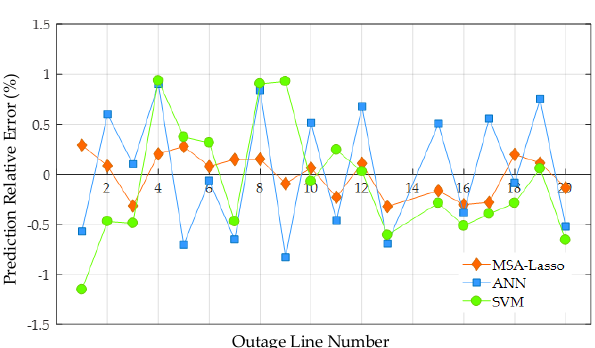
Figure 5. Security indices of each method in the base load condition of the IEEE 14-bus system.